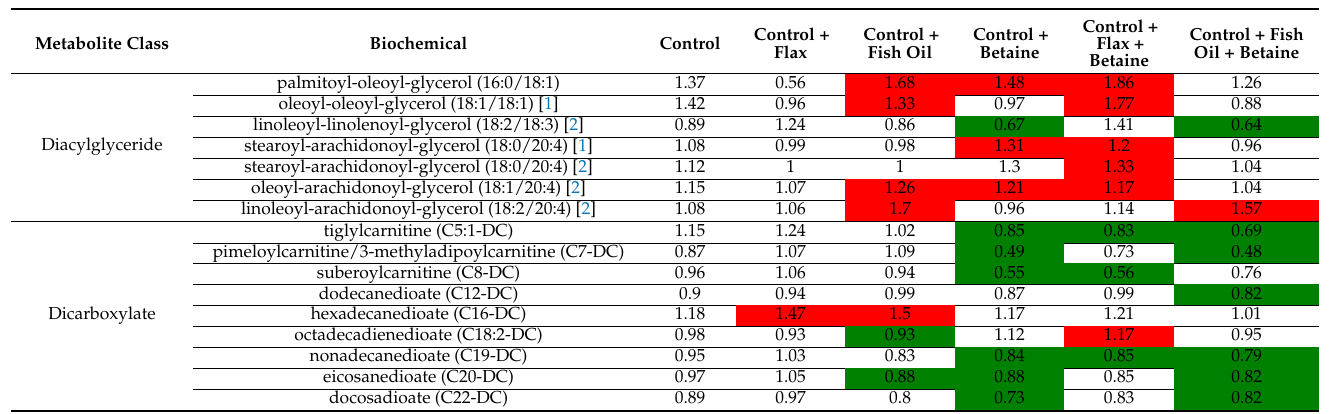
Table 6. Diacylglycerides and fatty acid dicarboxylates which changed during the study while consuming control, or betaine, flax, and fish oil supplemented foods